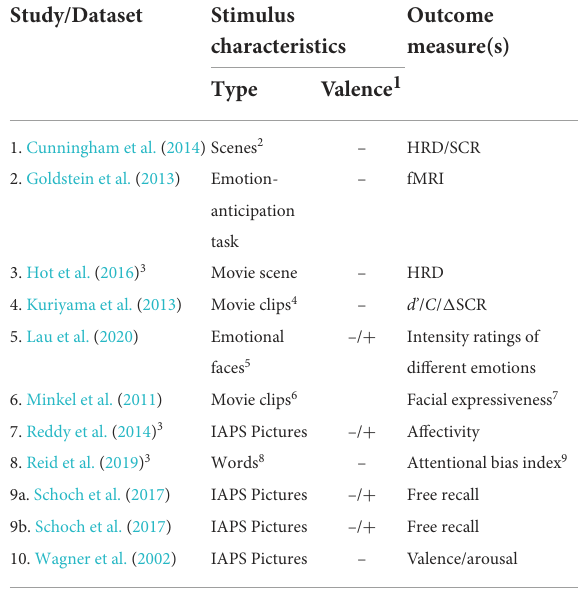
TABLE 4 Datasets included in the narrative analysis: Study stimulus characteristics and outcomes ( N = 10).